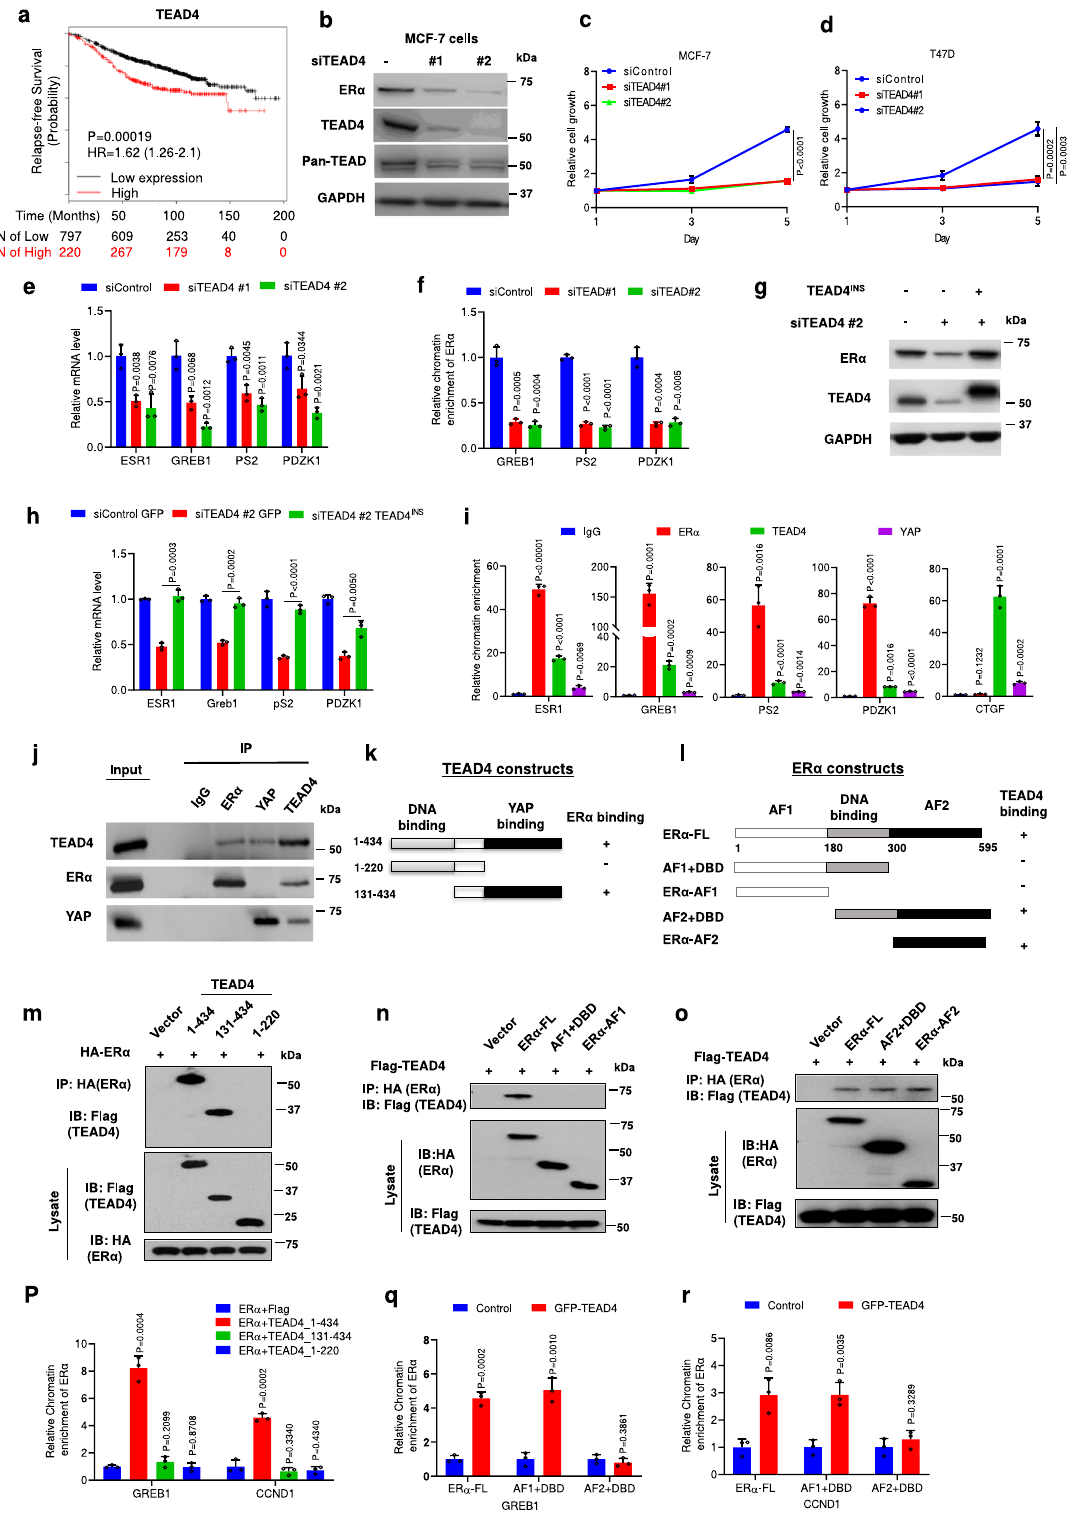
tamoxifen treatment can effectively control ER + breast cancer progression, many treated patients will eventually develop resis- tance. Hence, it is urgent and necessary to develop alternative therapeutic strategies to treat ER + breast cancer patients, espe- cially those who have developed drug resistance. Our fi nding that YAP may inhibit ER + breast cancer cell proliferation by